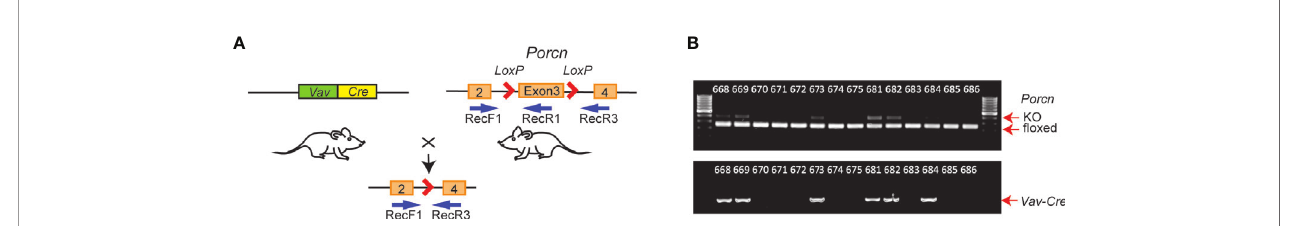
FIGURE 1 | Generation ofhematopoieticWnt-depletedmice. (A) Porcn fl ox mice were crossed with Vav-Cre mice, resulting in Vav-Cre/Porcn fl ox mice with excisional deletion of Porcn exon 3 inhematopoieticand other tissues expressing Vav-Cre . Relative annealing positionsofcomplementary primersused for PCR from mouse genomic DNA is shown(RecF1, RecR1, and RecR3). (B) PCR genotyping using DNA from tailclippings. Each lane isfrom an individual mouse. Upper panel, Vav-Cre/Porcn fl ox mice samples exhibited 2 bands, a faster 128 bpband from RecF1/RecR1 ( fl oxed), and a slower 248 bp band from RecF1/RecR3 (KO,knockout),since the tailclippings contain both hematopoieticand non-hematopoietictissue. Porcn fl ox mice inthe absence of Vav-Cre exhibitonly a singlePCR product (RecF1/RecR1).